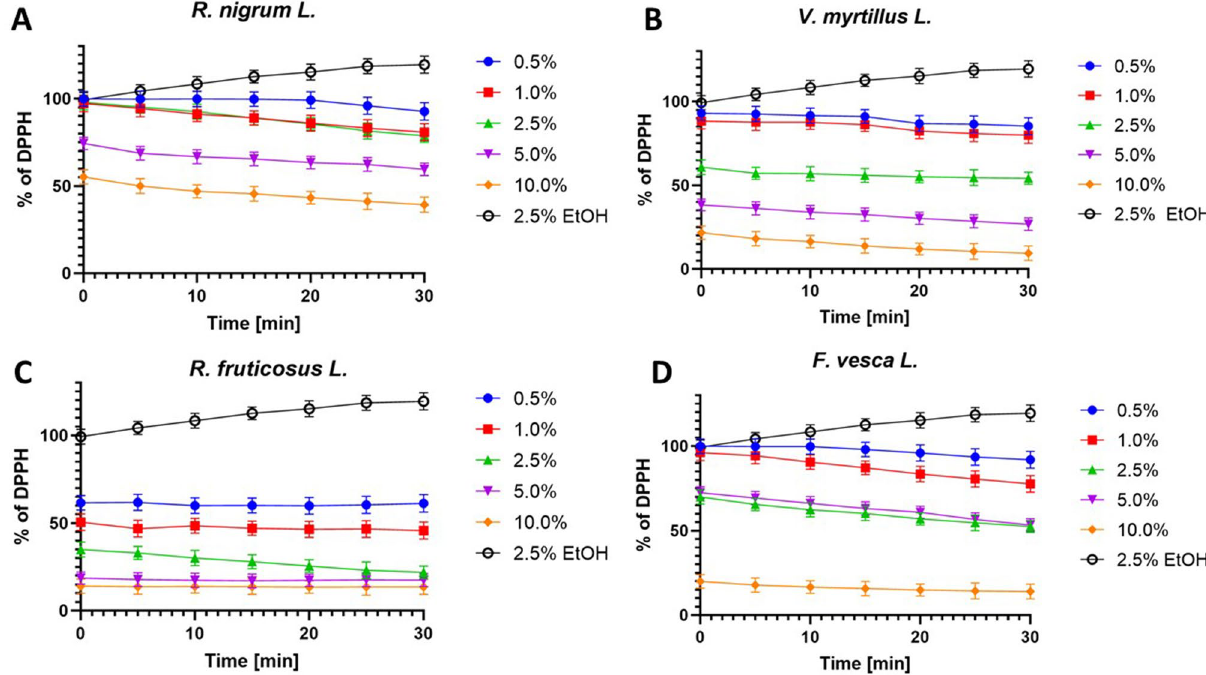
Figure 1. Kinetics of the absorbance changes in DPPH• solutions in the presence of various concentrations (0.5–10.0%) of water-glycerine extracts of R. nigrum L. ( A ) , V. myrtillus L. ( B ) , R. fruticosus L. ( C ) , and F. vesca L . ( D ). Values are mean of three replicate determinations (n = 3) ± SD. Negative control is: 0.25% ethanol